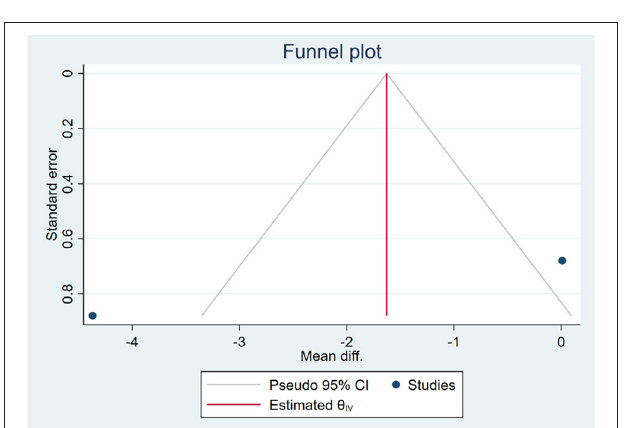
FIGURE 21 | Funnel plots of the effect of HOMA-IR.